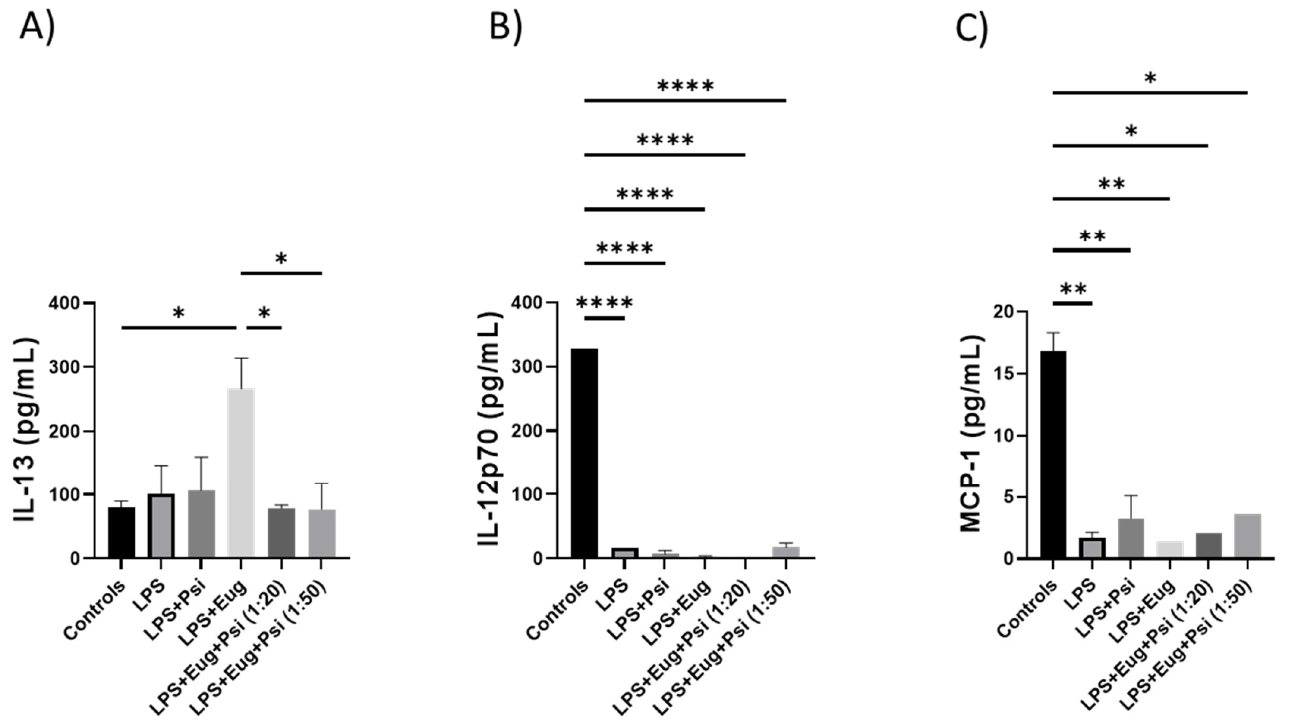
Figure 9. The content of pro-inflammatory cytokines in post-treatment LPS-induced inflammation in blood. The amounts of ( A ) IL-13, ( B ) IL-12p70, ( C ) MCP-1 were determined by ELISA. Data were analyzed with ANOVA and Tukey ( n = 1–3). Significance ( p ) is indicated within the figures using the following scale: *, p < 0.05; **, p < 0.01; ****, p < 0.0001. Bars represent mean ± SEM.